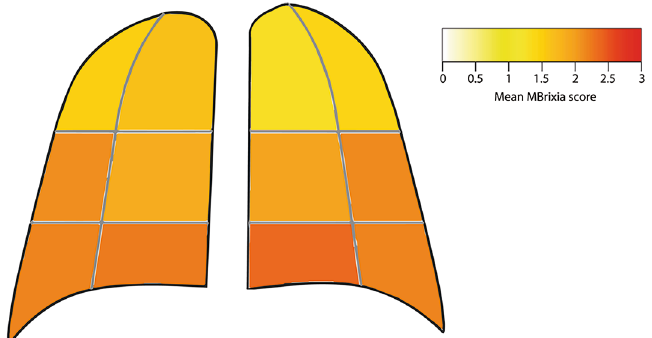
Figure 2. Distribution of lung lesions at time of maximum MBrixia score for 36 patients admitted to the hospital with COVID-19. One patient was left out of the analysis due to having a maximum score of zero.